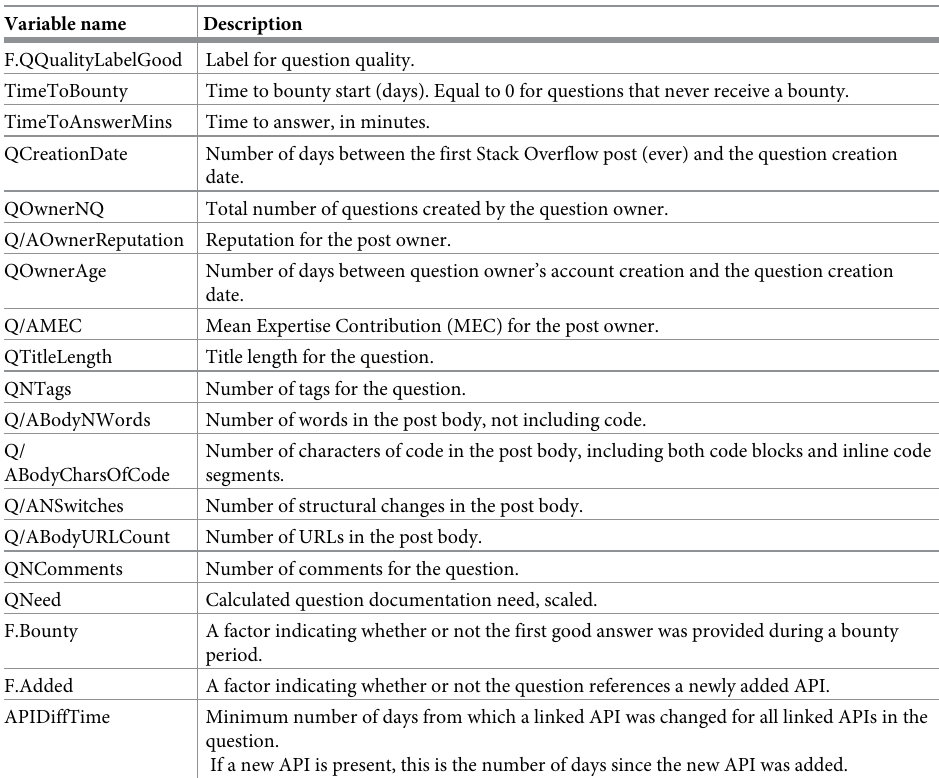
Table 1. Model variable